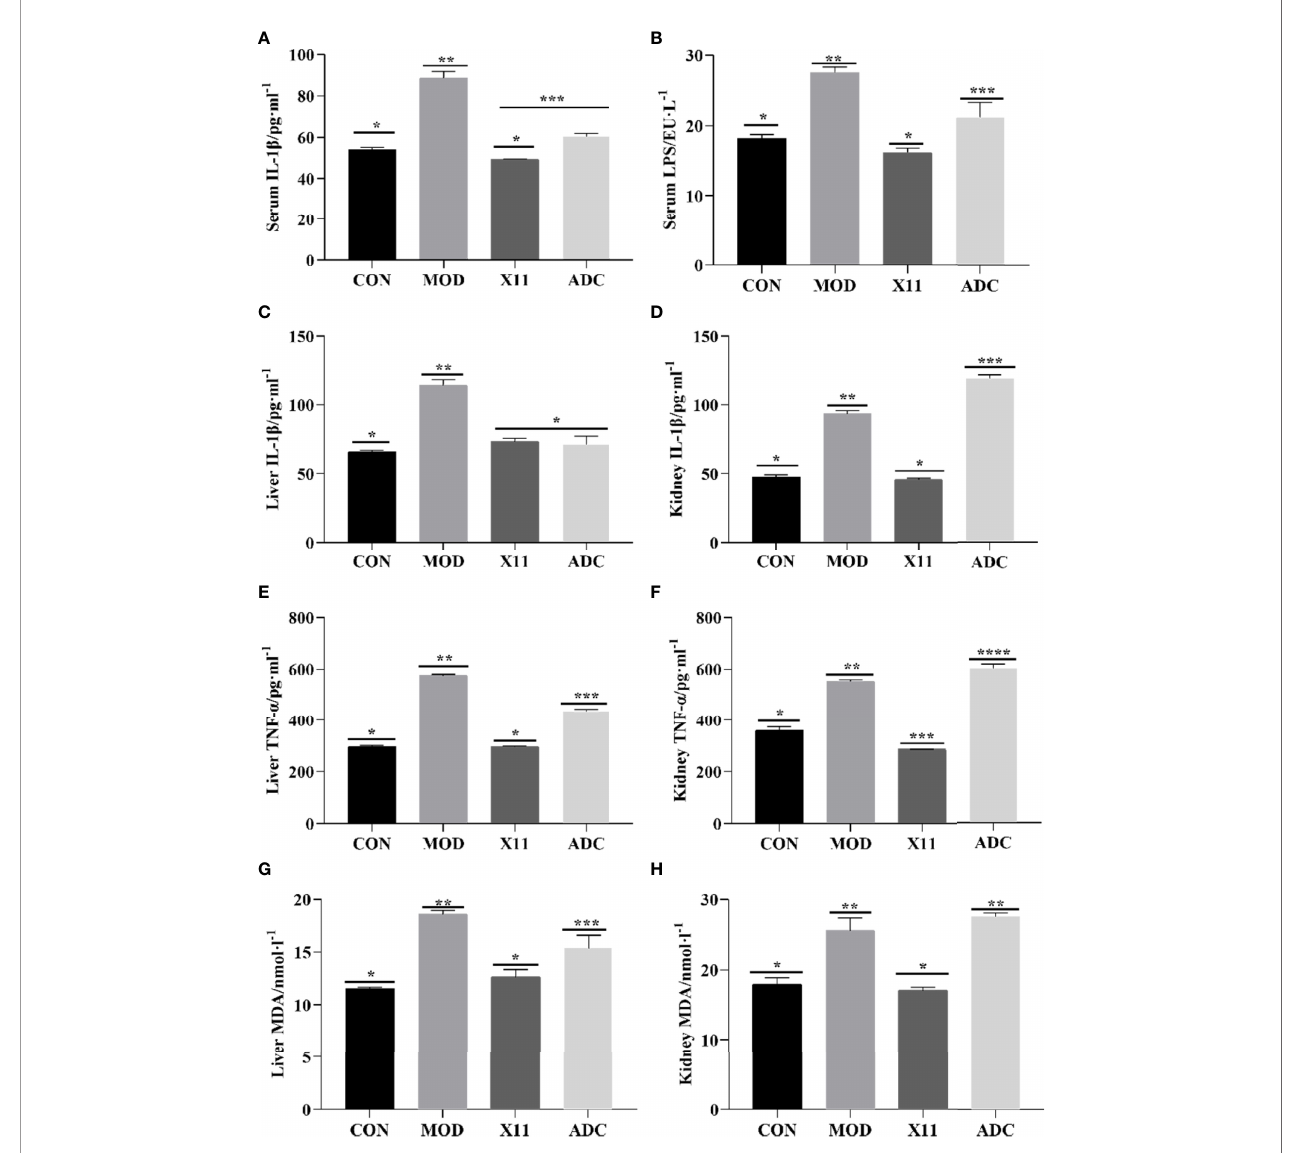
FIGURE 4 | Effects of Lactobacillus paracasei X11 on proin fl ammatory factors of mice. (A) Serum IL-1 b . (B) Serum LPS. (C) Liver IL-1 b . (D) Kidney IL-1 b . (E) Liver TNF- a . (F) Kidney TNF- a . (G) Liver MDA. (H) Kidney MDA. LPS, lipopolysaccharide; MDA, malondialdehyde. The same number of asterisks indicates no signi fi cant difference and the different number of asterisks indicates signi fi cant difference. (P <